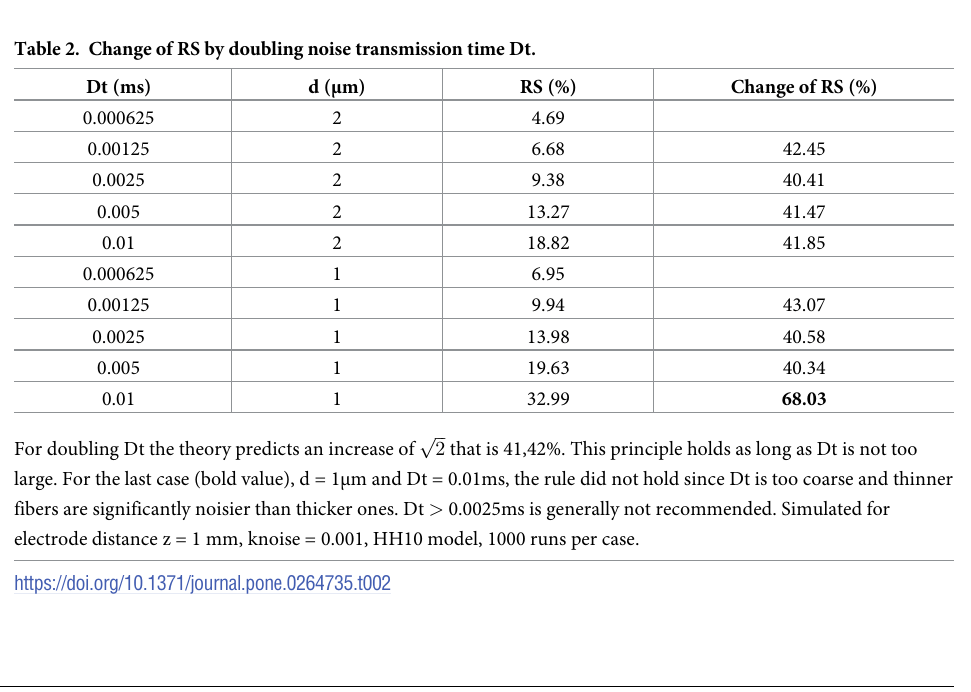
Table 2. Change of RS by doubling noise transmission time Dt.